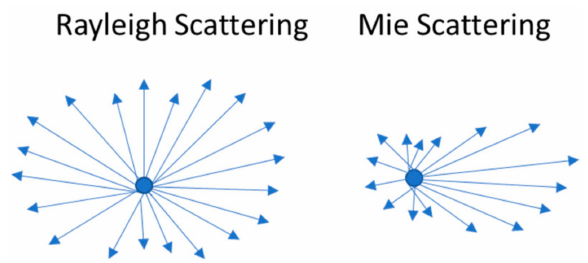
Figure 9. Rayleigh and Mie scattering